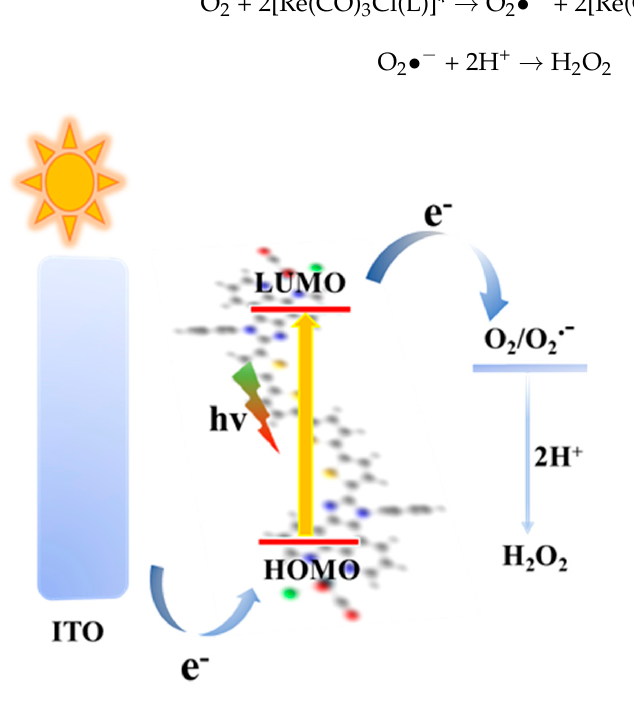
Figure 10. Proposed electron transfer mechanism of [Re(CO) 3 Cl(L)] on ITO for cathodic photocurrent generation and photoelectrocatalytic H 2 O 2 production.